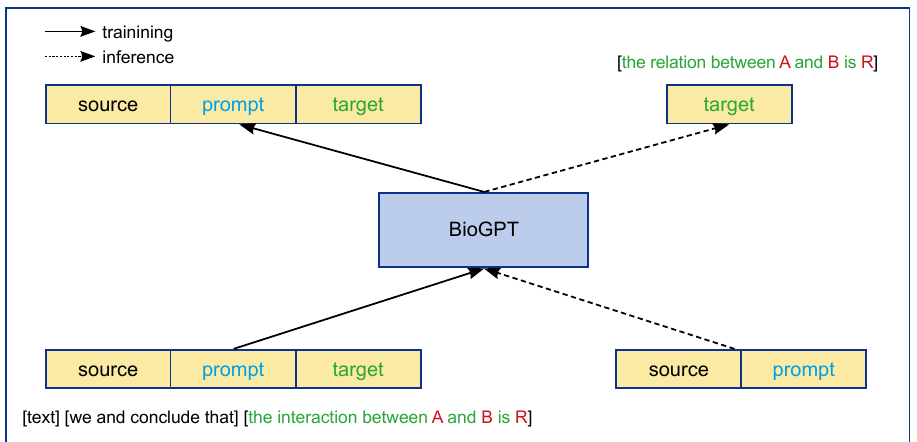
Figure 10 Schematic diagram of pre-training and fine-tuning stages of BioGPT. First, It splits biomedical text into words and turns each word into a word embedding vector for the input layer. Then it passes them through multi-layer one-way Transformer network to get a context sensitive hidden layer representation for each word. In the pre-training stage, the model parameters are optimized using the autoregressive language model objective function. The model predicts the next word by giving a text sequence. In the fine-tuning stage, a specific output layer is added depending on the downstream tasks, and the model parameters are fine-tuned by the task related data and objective functions [27].